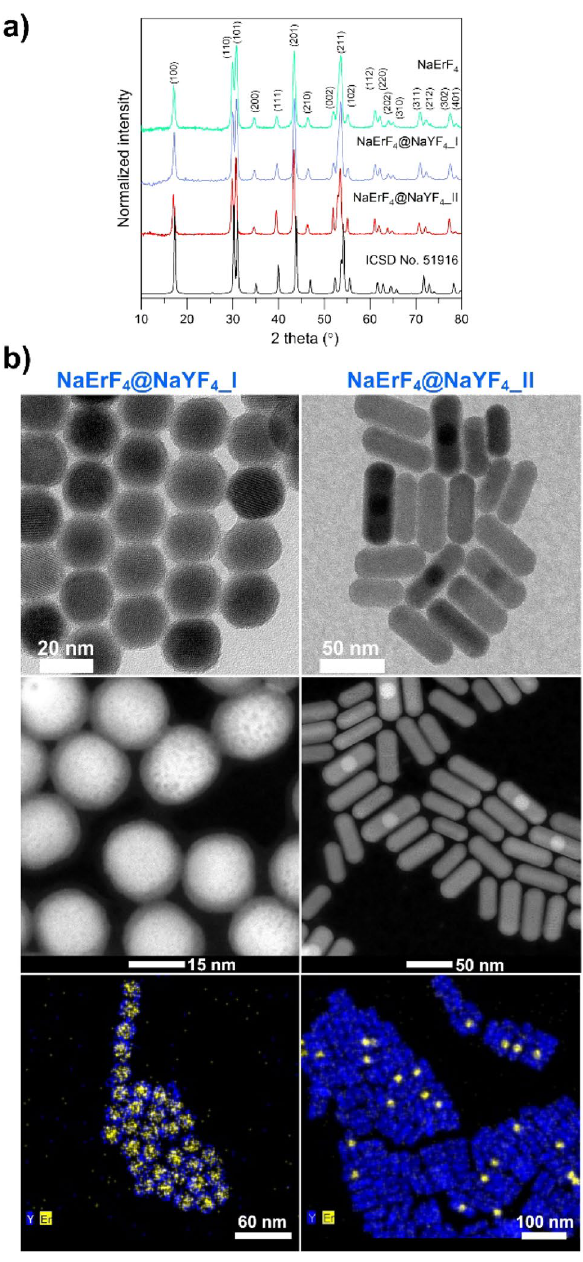
Figure 1. ( a ) XRD diffraction patterns of core and core@shell nanoparticles compared with the reference pattern of